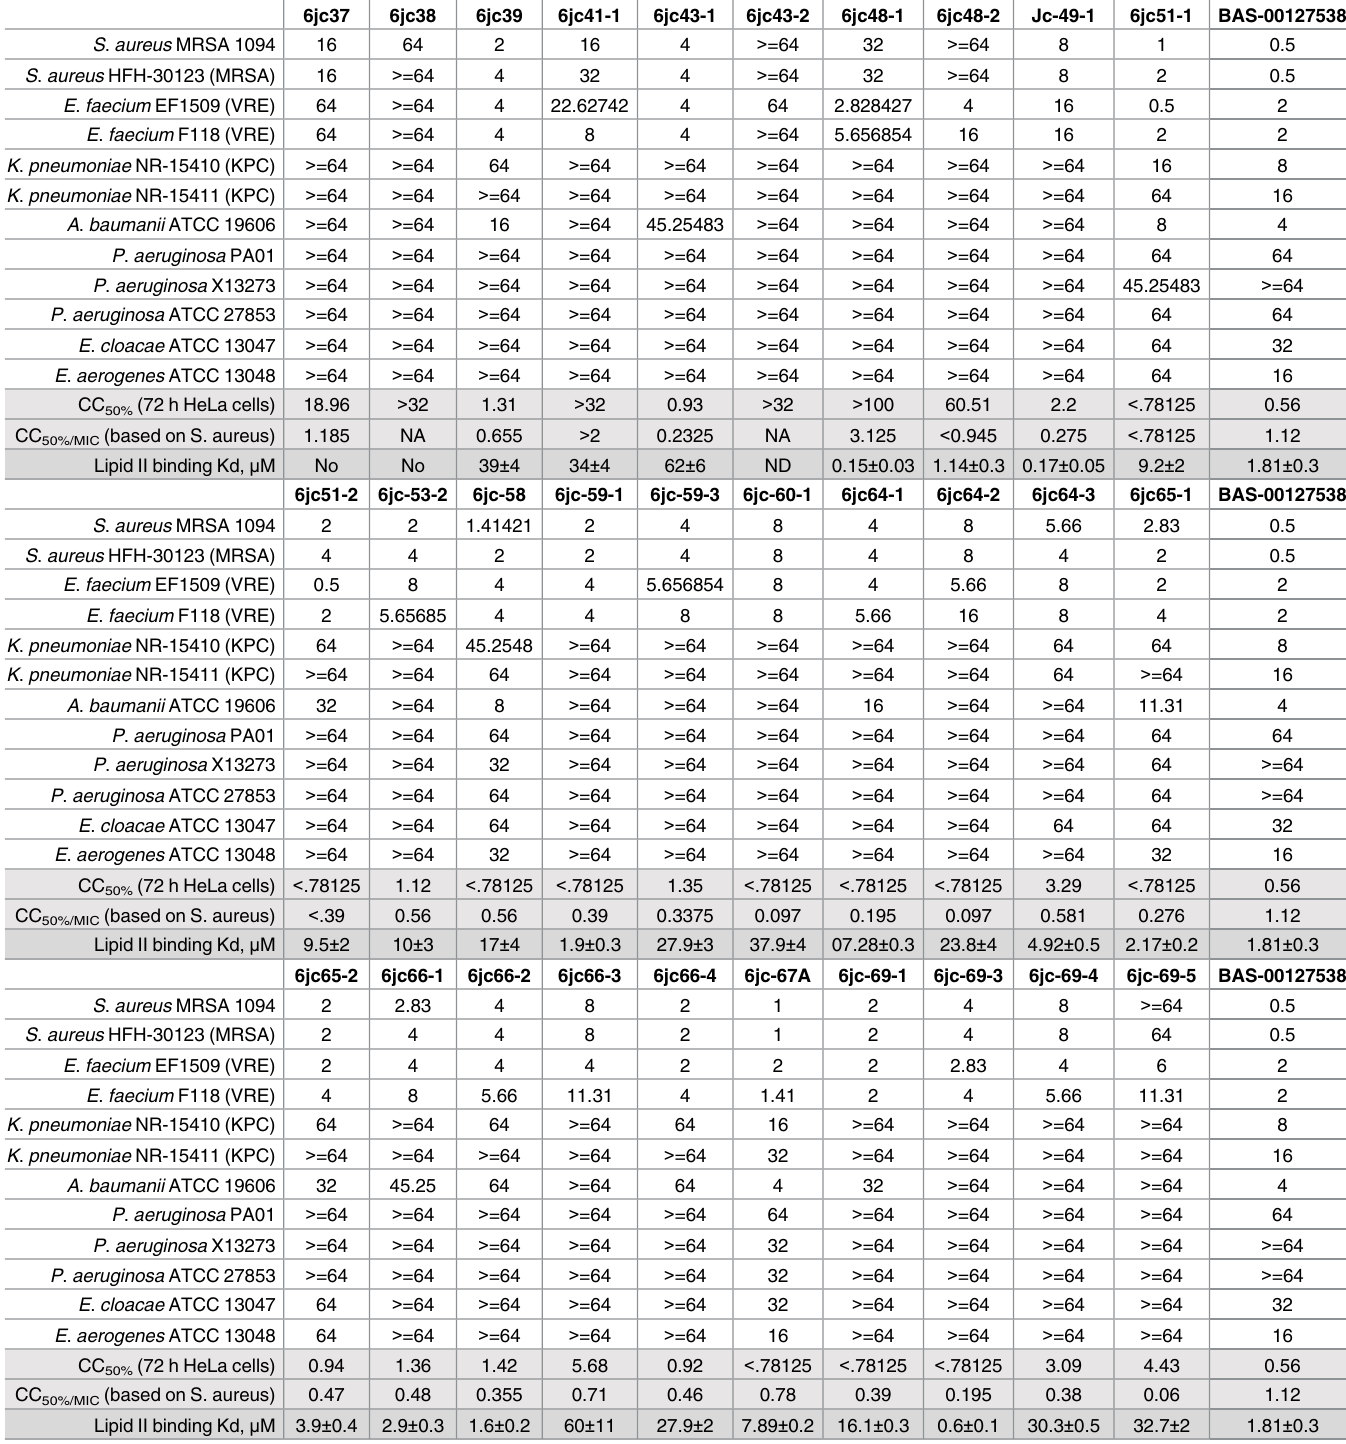
Table 1. Antibacterial activity, cytotoxicity and Lipid II binding of BAS00127538